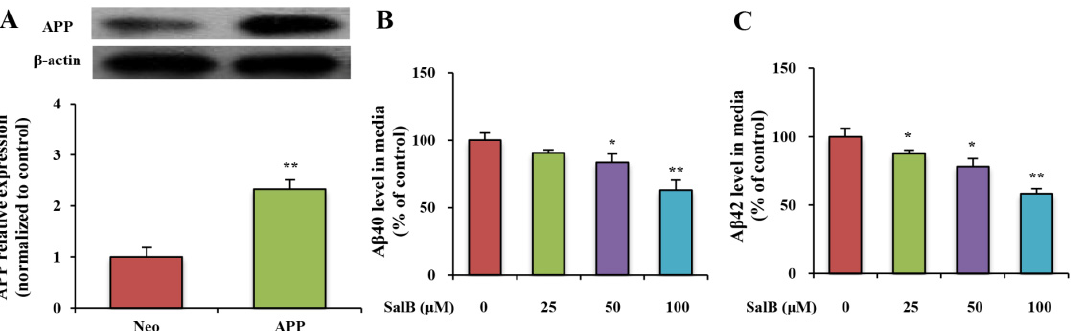
Figure 2. Effect of SalB on A β 40 and A β 42 levels in SH ‐ SY5Y ‐ APPsw cells. SH ‐ SY5Y ‐ APPsw cell was developed ( A ); A β 40 ( B ) and A β 42 levels ( C ) were measured in SH ‐ SY5Y ‐ APPsw cells. Values are expressed as the mean ± SD in each group ( n = 3). * p < 0.05, ** p < 0.01 vs. control. SalB: Salvianolic acid